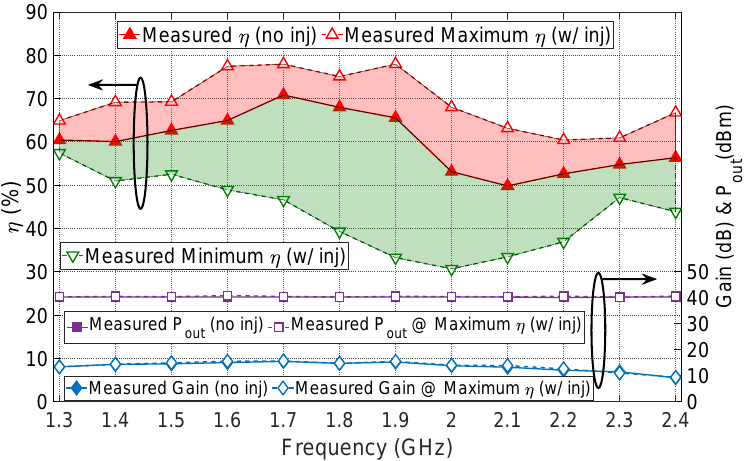
Figure 7. Simulation and CW measurement results before and after second-harmonic injection using the clockwise-loaded class-J theory with low gain